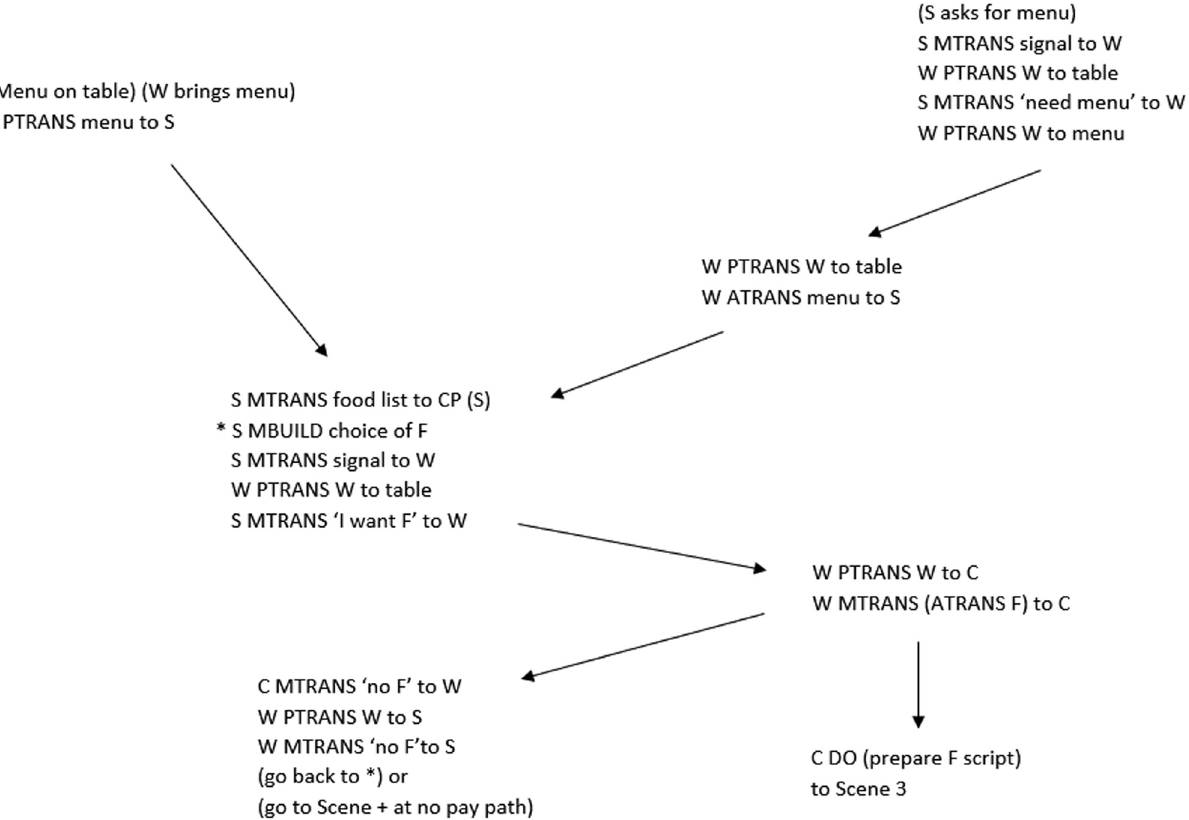
Figure 1: Schank ’ s example of a restaurant script [ 11 ]